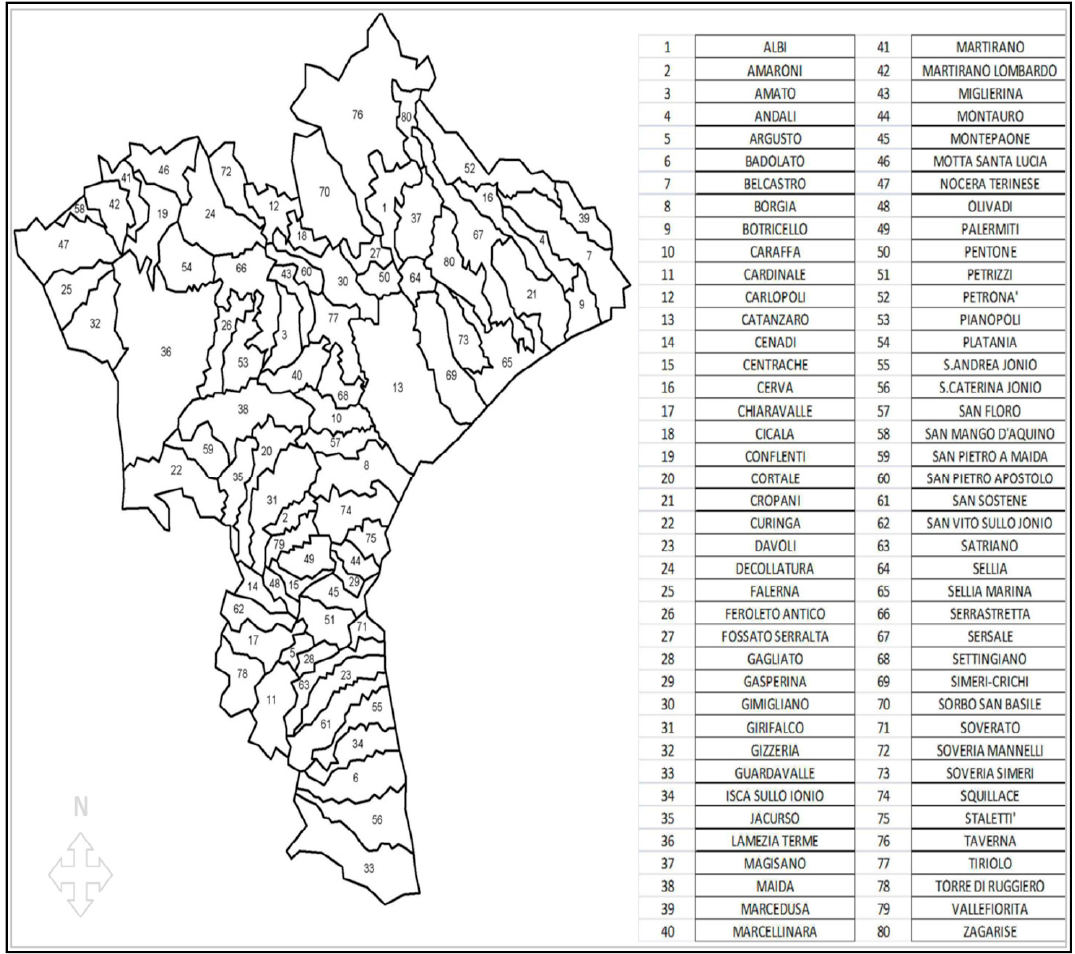
Figure 2. Municipalities of the province of Catanzaro.